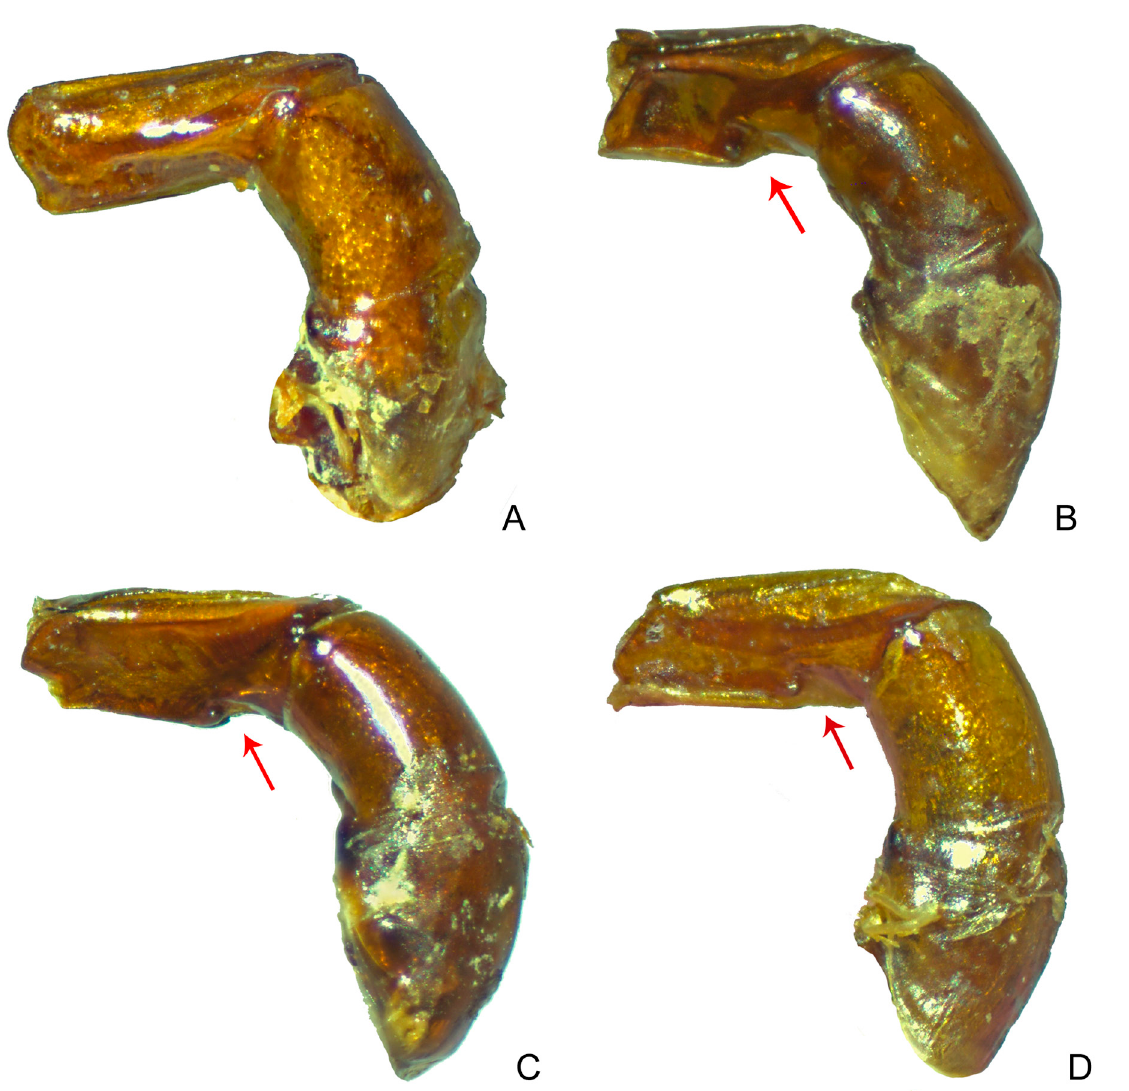
Fig. 18. Aedeagus morphological diversity in the bridarollii subgroup. A . S. bridarollii (Martínez, 1949). B . S. seag sp. nov. (arrow points to the ventral notch). C . S. edmondsi sp. nov. (idem). D . S. attenboroughi sp. nov.